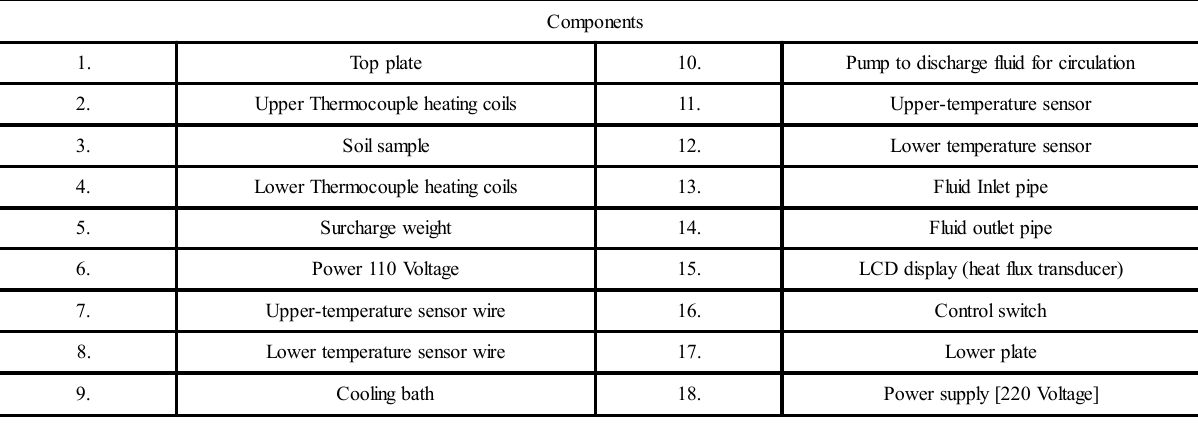
TABLE 2. COMPONENTS OF THERMAL CONDUCTIVITY SETUP